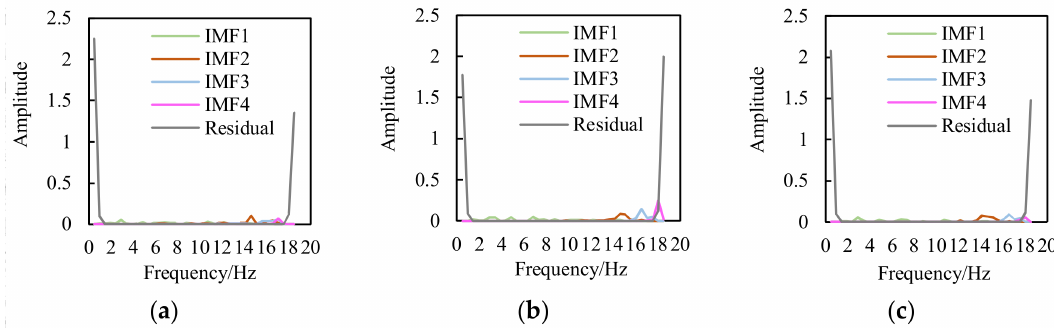
Figure 3. Hilbert spectrums and marginal spectrums of runoff components obtained based on ( a ) SD criteria; ( b ) GR criteria; and ( c ) MTED at the Zhaoshiyao station.